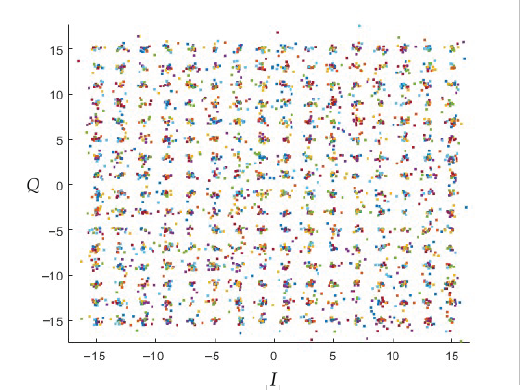
Figure 11. QAM constellation for N = 2 2 i × 2 2 i , i = 3 on the MIMO channel, SNR = 60 [ dB ] .